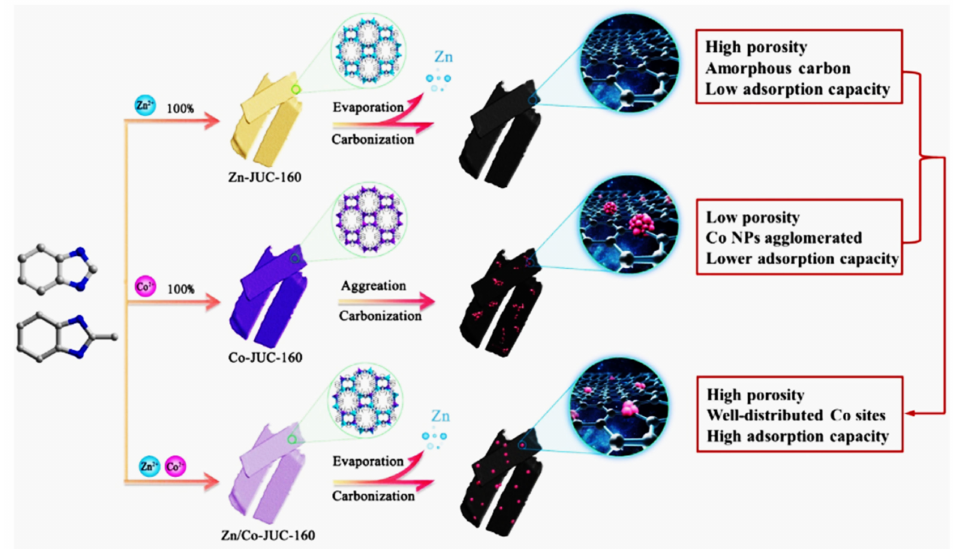
Figure 25. Synthesis strategy for porous carbons derived from Zn-JUC-160, Co-JUC-160, and Zn/Co- JUC-160 ZIF (NC, Co@NC-x/y composites and Co@NC). Reprinted with permission from